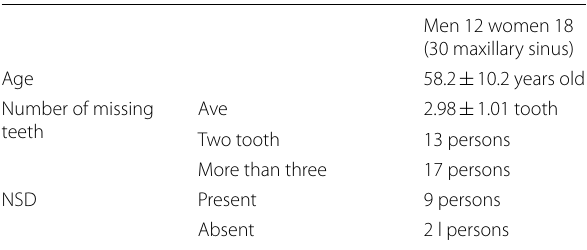
Table 2 MSV overall and by missing teeth, NSD, and sex